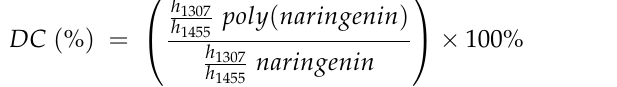
Figure 6. UV-Vis spectra of naringenin and poly(naringenin) powders. In the next stage of re- search, the thermal properties of naringenin and poly(naringenin) were investigated. The thermal stability of monomeric and polymeric forms of the flavonoid were established using thermogra- vimetry, TG. The results of the examinations are shown in Figure 7 and Table 1.